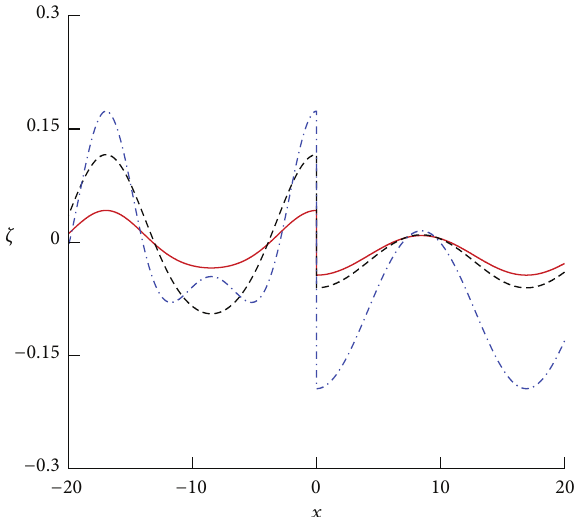
Figure 4: Variation of incident progressive waves and hydroelastic deflection of the plate versus 𝑥 for different amplitudes 𝑎 0,1 of initial incident wave. Solid line: 𝑎 0,1 = 0.05 m; dashed line: 𝑎 0,1 = 0.1 m; dash-dotted line: 𝑎 0,1 = 0.2 m.